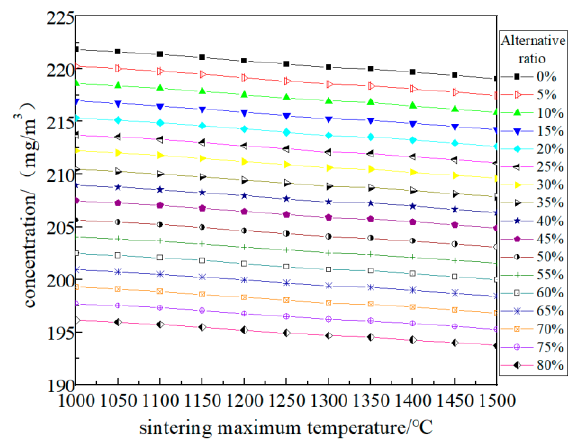
Figure 11. Change of CO 2 emission concentration in the case of straw charcoal